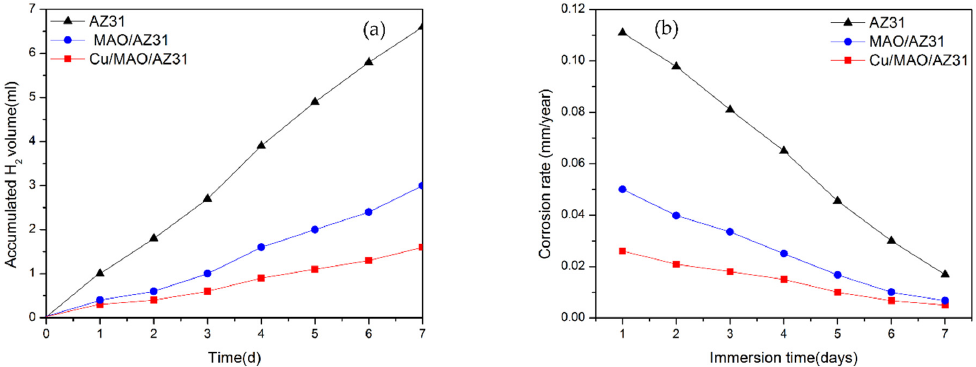
Figure 7. ( a ) H 2 evolution test for substrates immersed in SBF for 7 days; ( b ) corresponding corrosion rate.